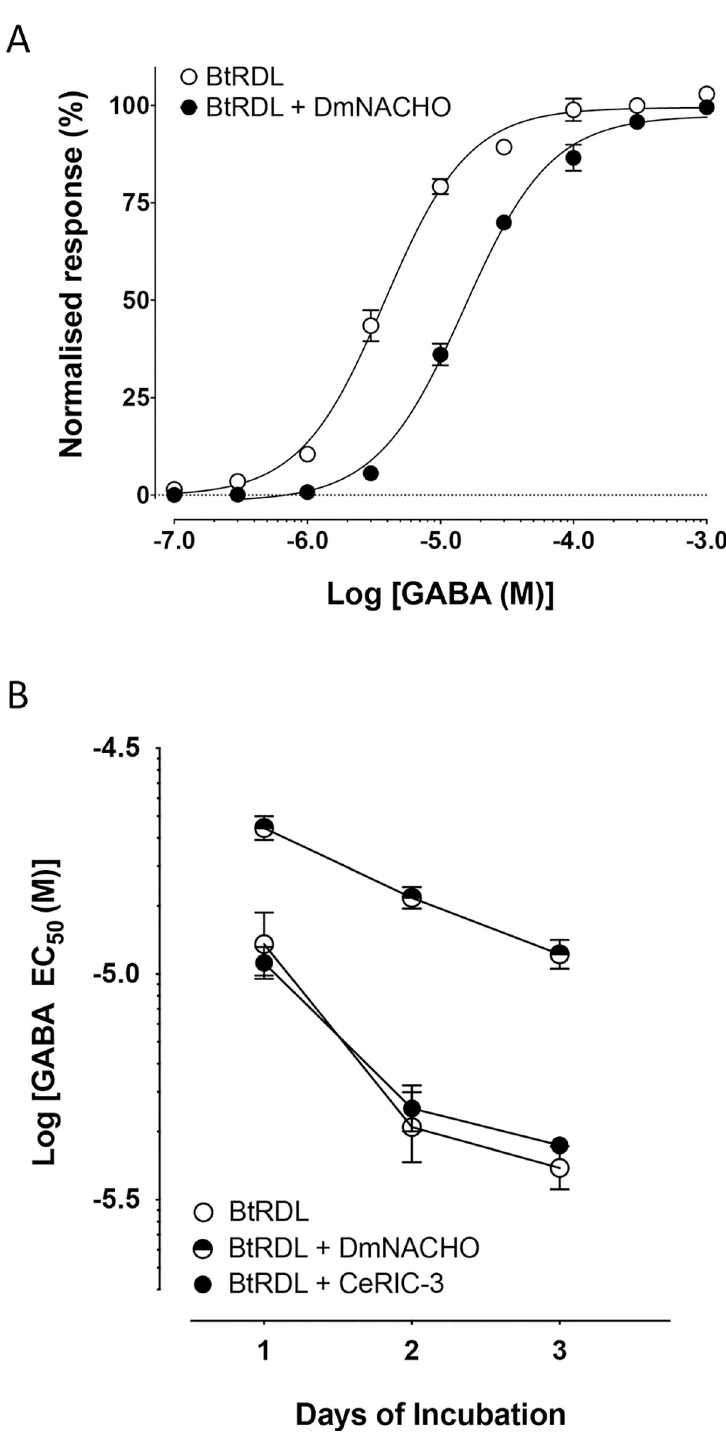
Fig 5. Influence of chaperone proteins DmNACHO and CeRIC-3 on apparent affinity of BtRDL. A) GABA dose- response curves were generated from oocytes injected with cRNA (1 ng) synthesised from pSP64GL-BtRDL after digestion with Bam HI to retain the 3’UTR, in the presence (filled circles) or absence (open circles) of cRNA (10 ng) encoding DmNACHO and recorded two-days post-injection. B) GABA EC 50 values determined from oocytes injected with cRNA (1 ng) synthesised from pSP64GL-BtRDL after digestion with Bam HI to retain the 3’UTR and recorded as one-, two- or three-days post-injection. Data are presented for BtRDL expressed alone (open circles), co-expressed